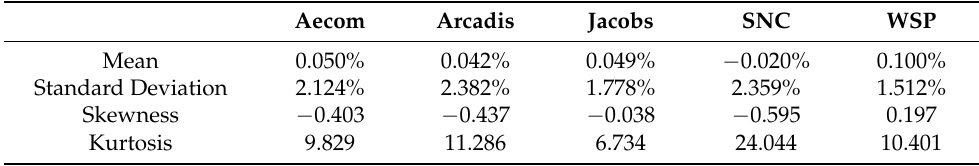
Table 1. Descriptive statistics for the five largest consulting engineering companies in the world.